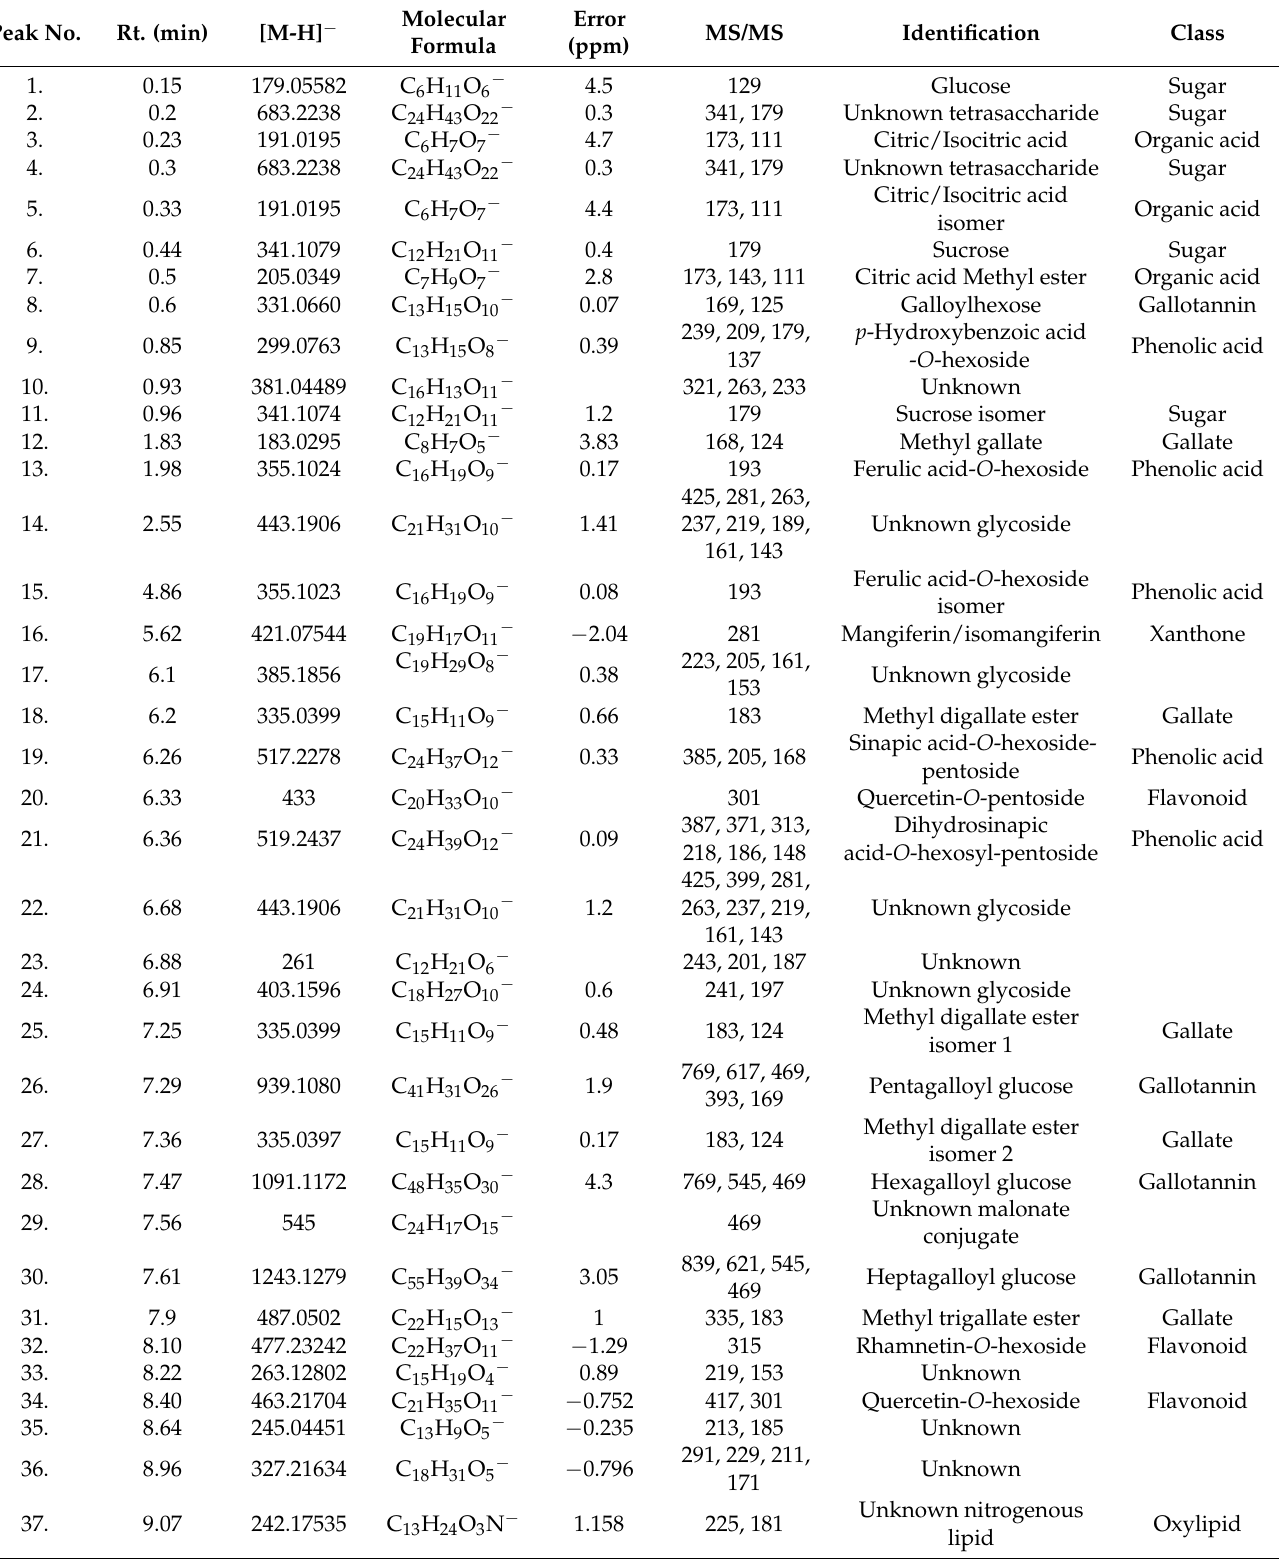
Table 2. List of annotated metabolites in mango fruits using UPLC/MS detected in negative ionization mode and their